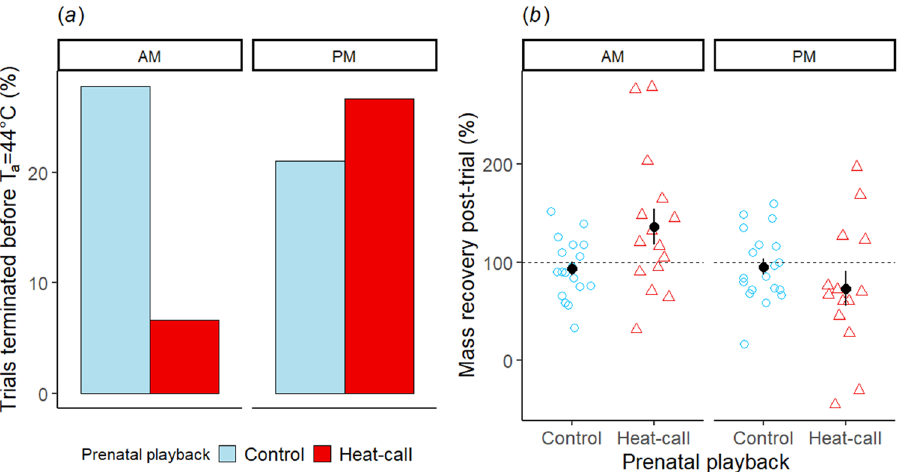
Figure 1. Effects of prenatal playback and time of day (AM or PM) on ( a ) the proportion of trials (n = 67 for 34 birds) terminated before T a = 44 °C on account of birds showing signs of severe heat stress, and on ( b ) post-trial mass recovery (n = 66 for 34 birds). In ( b ), markers and error bars show mean ± SE and the dashed line corresponds to a total recovery of the mass lost during the trial (i.e. 100%). Points are jittered horizontally to facilitate visualisation. Birds had been prenatally exposed to either (i) heat-calls that incubating parents exclusively produce at high temperatures (treatment, red) or (ii) parental contact calls (control,